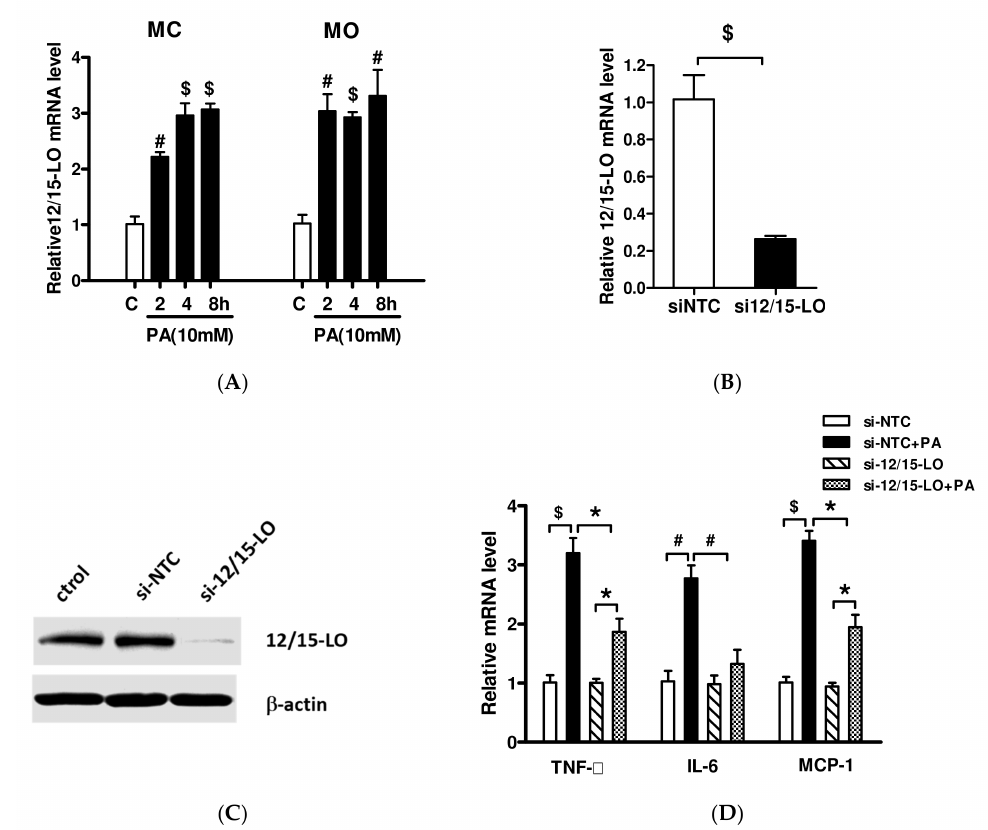
Figure 2. Inhibition of 12/15-LO expression on palmitic acid-regulated inflammatory factor expres- sion. ( A ) Palmitic acid (PA, 10 mM) added to MCs and MOs to mimic high-fat stimulation and then observed intracellular 12/15-LO expression; ( B , C ) MCs were transfected with siRNAs specific to 12/15-LO (si-12/15-LO) or non target control (si-NTC) oligonucleotides, gene expressions were detected by WB and RT-qPCR assays. Data represented as mean ± SEM, n = 3. $ p < 0.001 versus siNTC. ( D ) Transfected MCs were added to PA (10 mM) for 8 h and gene expression of TNF- α , IL-6, and MCP-1 was analyzed by RT-qPCR. Results are expressed as fold over siNTC (mean ± SEM, n = 3. * p < 0.05, # p < 0.01, $ p < 0.001 vs.siNTC or